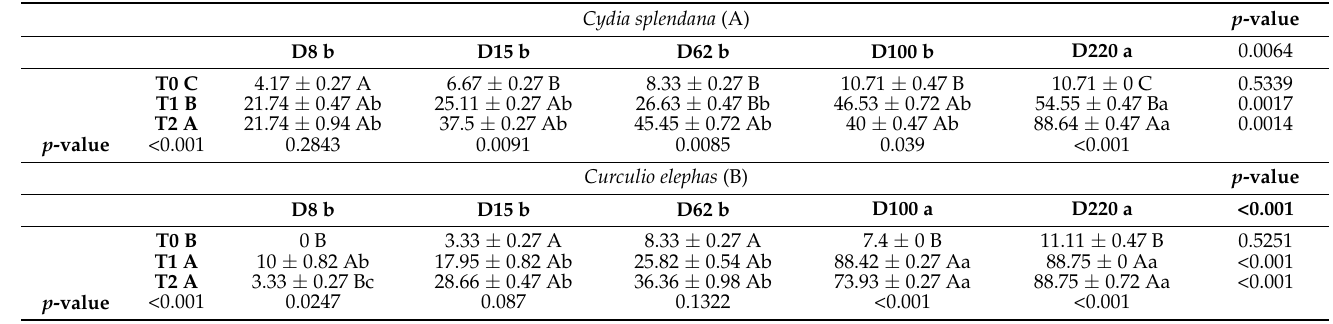
Table 2. Percentage of total mortality (including death and infection) of chestnut moth, Cydia splendana (Hübner) (A), and chestnut weevil, Curculio elephas (Gyllenhal) (B) larvae in the different modalities on days 08, 15, 62, 100 and 220 after treatment. Insect mortality was corrected for the control treatment (natural mortality) using the Schneider-Orelli formula. Cydia splendana